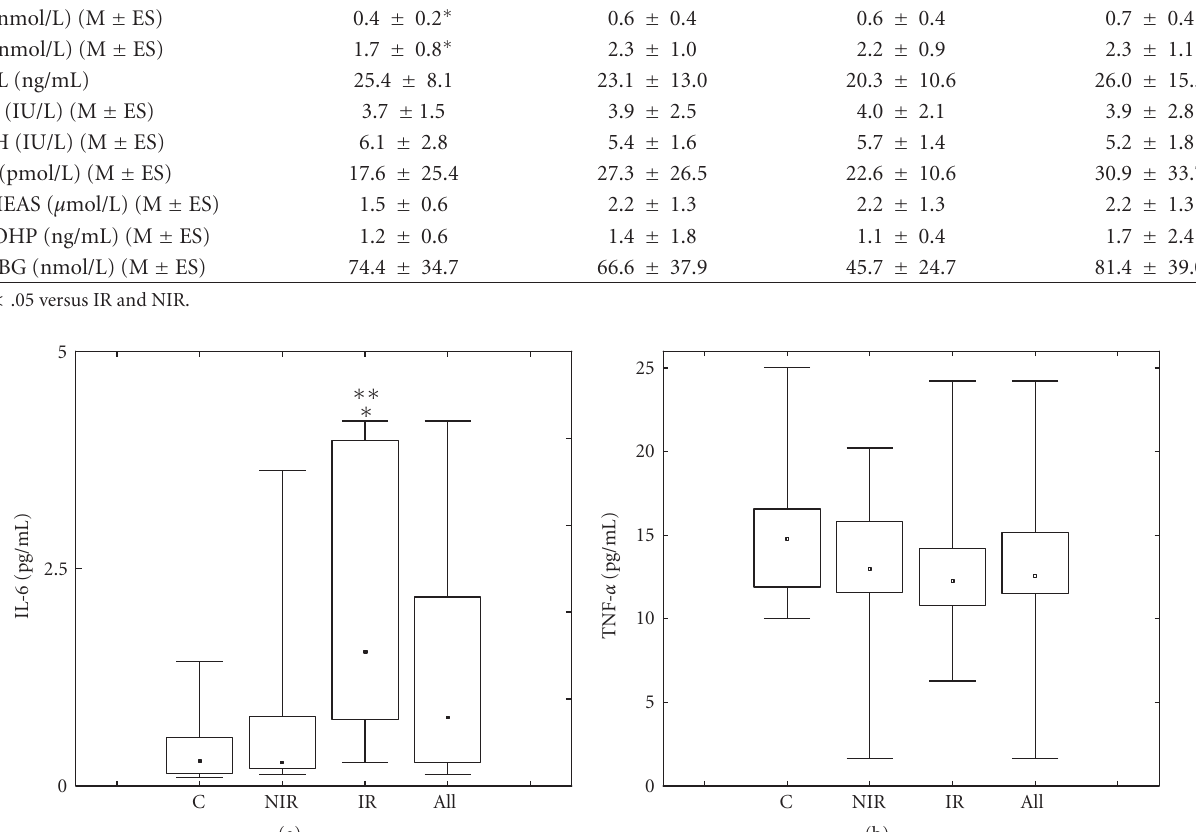
Figure 2: TNF- α and IL-6 levels in PCOS and control girls. Due to the strongly asymmetric distribution of data, the graph shows the median (middle bar), interquartile ranges (boxes), and min-max ranges (end bars). P < .005 by Mann-Whitney U test.